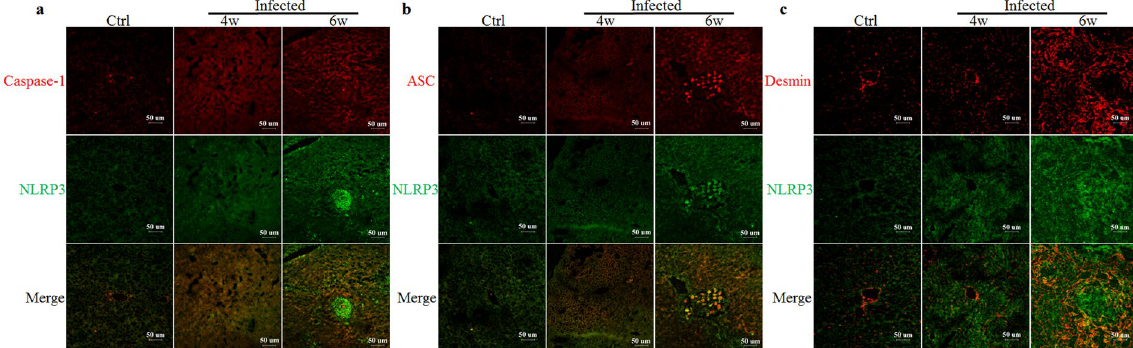
Figure 3. Confocal fluorescence images of NLRP3 inflammasome formation in the livers of mice infected with S. japonicum : the co-localization of NLRP3 with caspase-1 ( a ), ASC ( b ) and desmin ( c ). Ctrl: control (n = 4); 4w: mice infected with S. Japonicum for 4 weeks (n = 6); 6w: mice infected with S. japonicum for 6 weeks (n = 6). Results are a representative of at least three independent experiments.